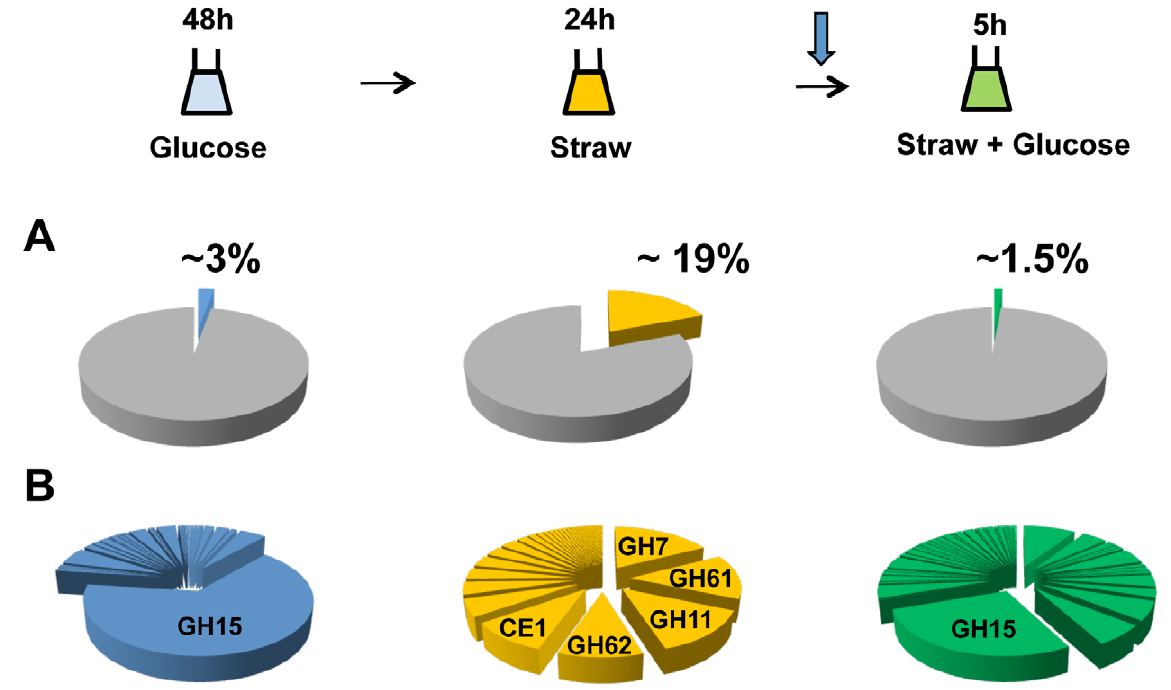
Figure 2. CAZy gene expression. The sampling conditions are shown for the RNA-seq study. Cells were grown in glucose (48 h), washed and transferred to straw (24 h) and then glucose was added (downward arrow) followed by a further 5 h incubation. (A) Percentage of total mRNA (calculated from RPKM values) represented by CAZy family genes from each condition of the transcriptome study. (B) Proportions of total of CAZY gene mRNA from each enzyme family. The families are listed in decreasing order of expression in the Straw 24 h condition.